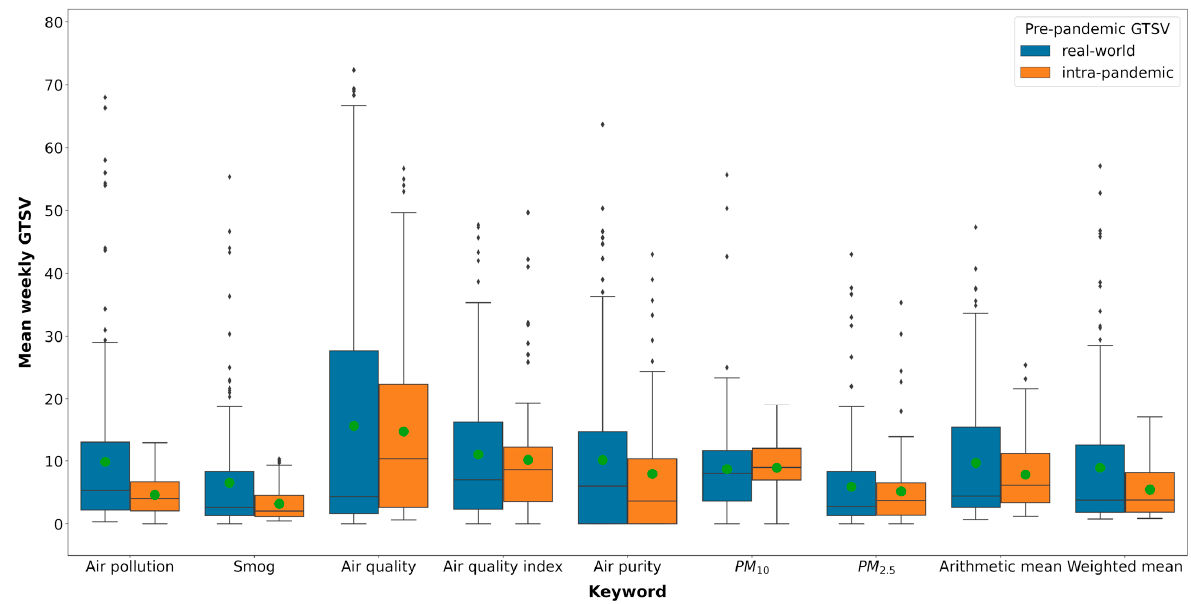
Figure 1. Comparison of the real-world pre- and intra-pandemic GTSVs. Green dots represent the mean values. Table 2. Comparison of the real-world pre- and intra-pandemic GTSVs.